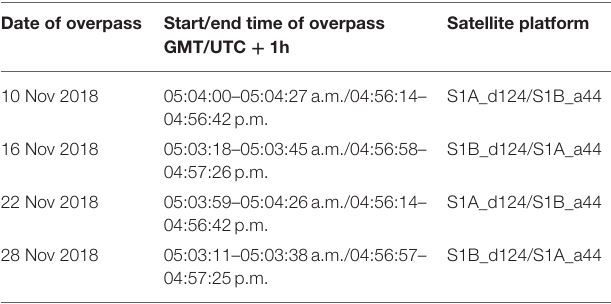
TABLE 2 | Dates with start and end time of overpasses of the satellites Sentinel-1 A/B (S1A/B) during the observation period in Nov. 2018. Date of overpass Start/end time of overpass GMT/UTC +